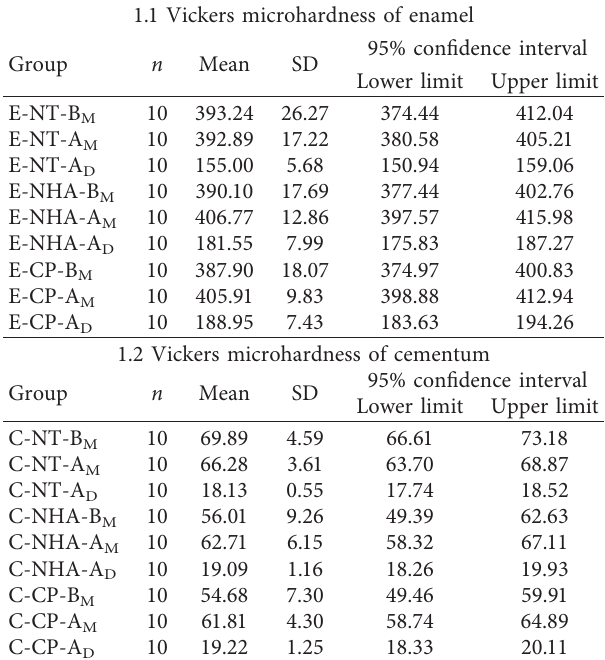
Table 1: Mean, standard deviation (SD), and 95% confidence interval of Vickers microhardness (VHN) of enamel (E) and ce- mentum (C) before material application ( B M ), after material ap- plication ( A M ), and after inducing demineralization ( A D ) with nanohydroxyapatite (NHA), Clinpro (CP), and no treatment